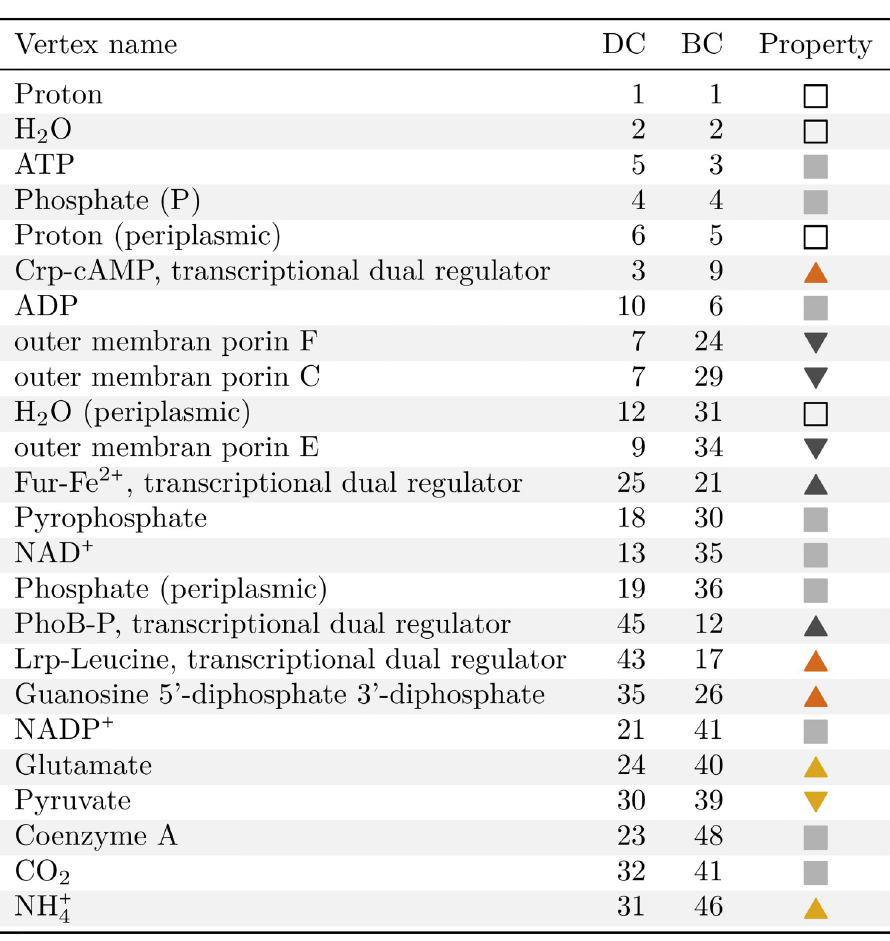
Fig 8. Key elements of the integrative E. coli network. Key elements with respect to degree (DC) and betweenness centrality (BC) are listed according to their rank as well as their functional characteristic and cross-systemic property, respectively. Open squares denote trivial compounds and filled squares indicate currency metabolites. The colored arrows depict the cross-systemic contribution—downwards interface-related ( ▼ ), upwards interface-related ( ▲ ). The orange arrows emphasize the cross-systemic components with significant low intra-domain degree fraction and the golden ones point out elements indirectly linking to one of the major traversing paths systems.